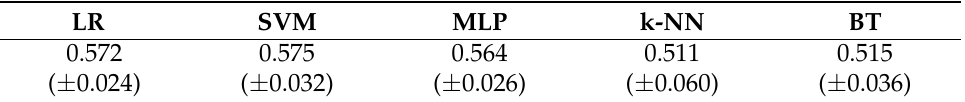
Table 12. AUC for different classifiers with the pre-menopausal data partition (without performing feature